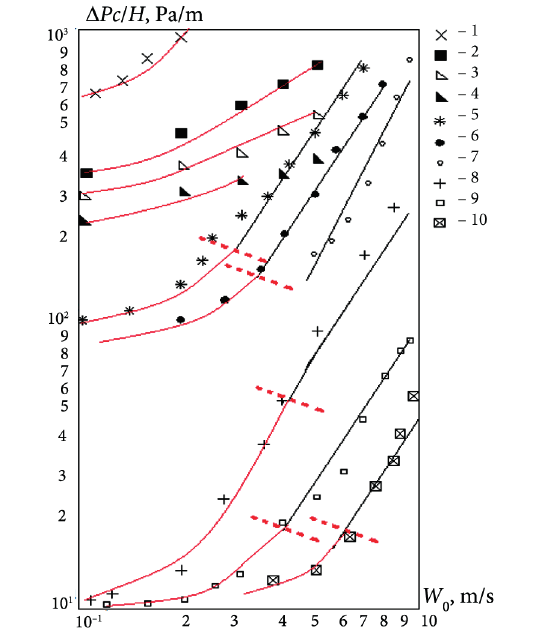
Fig. 8. Dependence of the pressure drop ΔP /H on the gas c velocity W per full cross-section of empty apparatus for the 0 following dry packings: 1 – Active carbon SKT2; 2 – mix of wood chips, bark and zeolite granules; 3 – mix of wood chips, bark, granules of zeolite and foam rubber cubes; 4 – mix of wood chips, bark and foam rubber cubes (Pushnov et al. 2012); 5 – Combined packing (Mitin et al. 2014); 6 – Ceramic Raschig rings; 7 – Metal Raschig rings (Pushnov, Kagan 2011); 8 – HPCM packing (Mitin et al. 2014); 9 – pine cones (our experiments); 10 – Mellapak 250Y (Chavez, Guadarrama